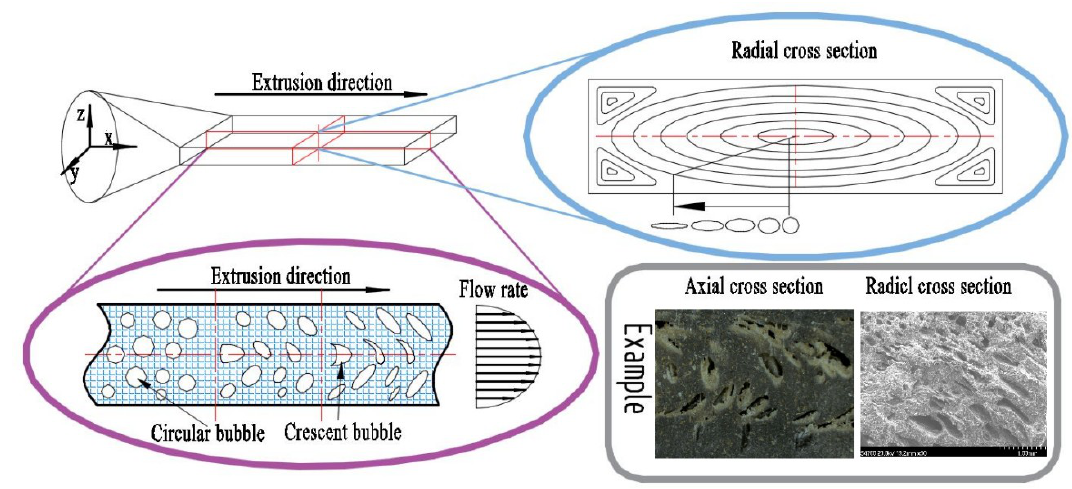
Figure 6. Schematic illustration of cell formation in the sheet die.